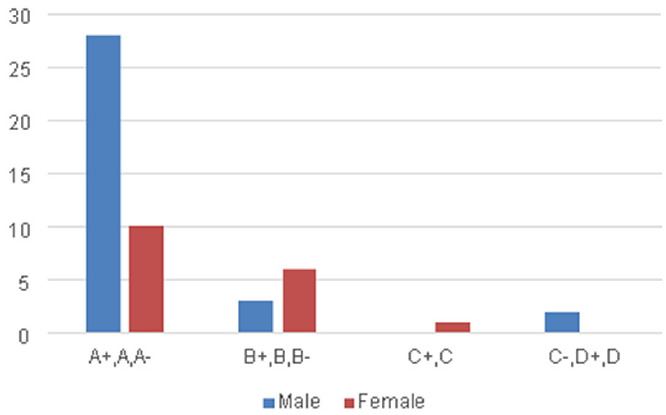
Fig. 6. Course grade, by